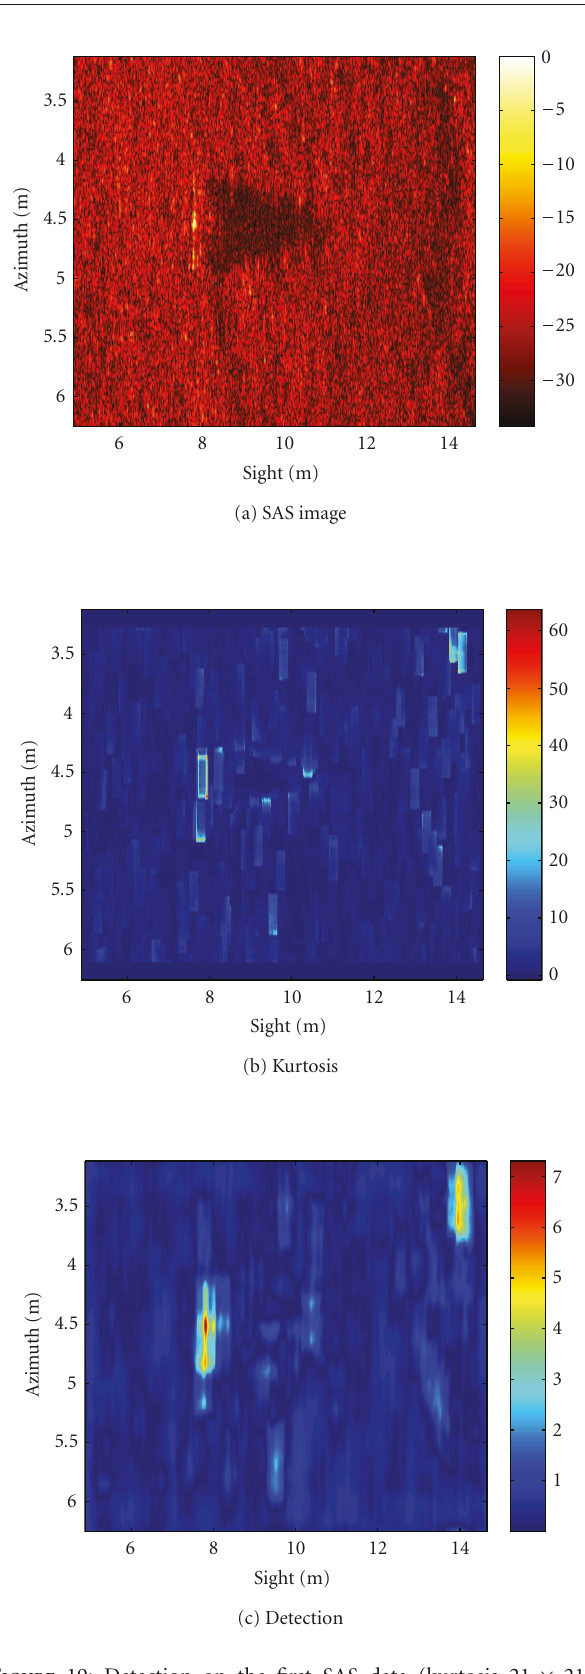
Figure 19: Detection on the first SAS data (kurtosis 21 × 21, matched filtering 25 × 25, SD =